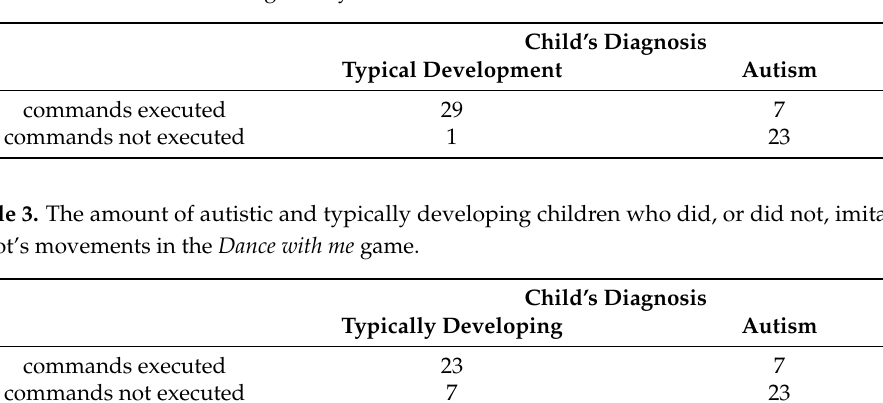
Table 2. The amount of autistic and typically developing children who did, or did not, perform the Touch me commands that were given by the robot.